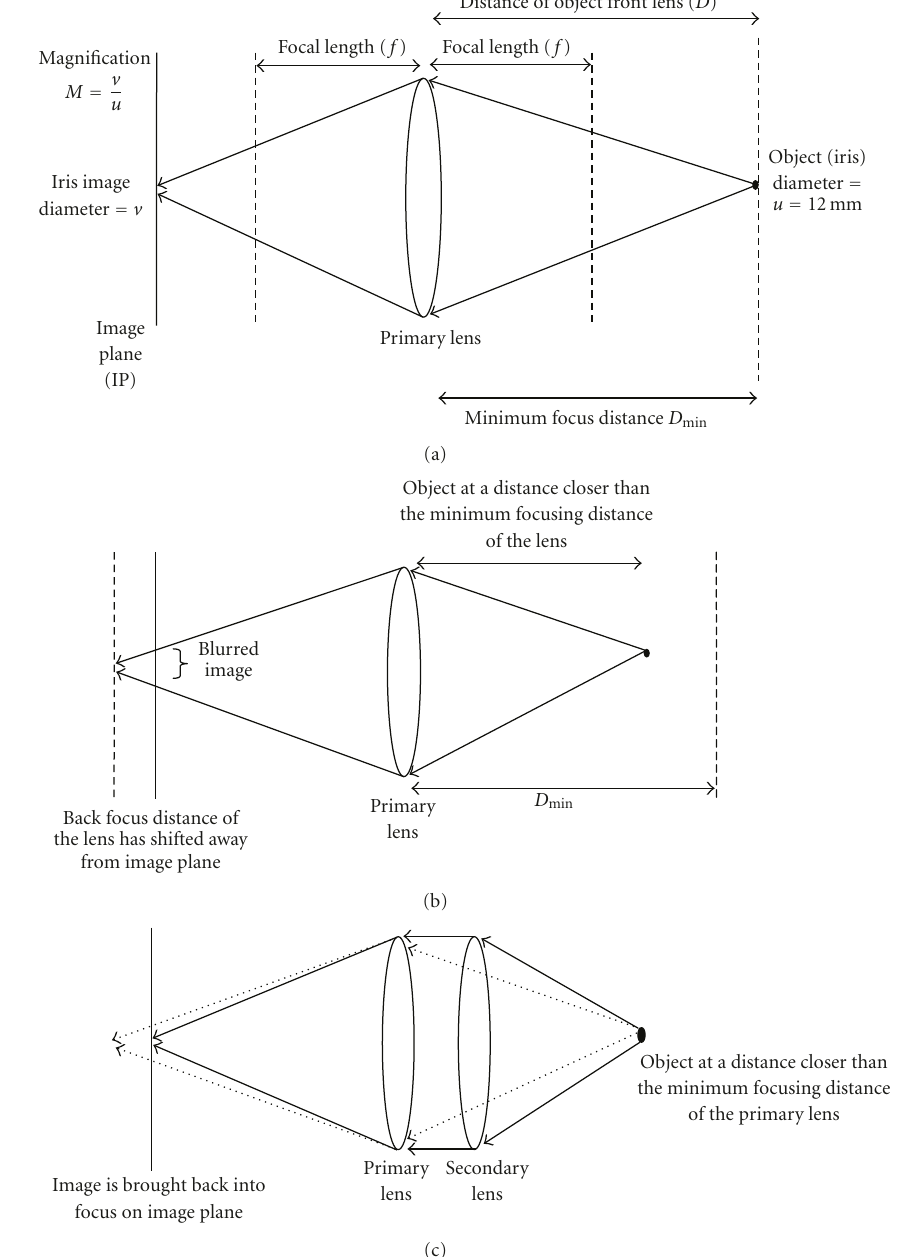
Figure 3: The figure illustrates how a secondary converging lens, used along with the primary lens, reduces the minimum focus distance of the system. (a) Shows an object place farther away than the minimum focus distance D min from the primary lens. (b) Shows an object placed closer to the primary lens. Here, the object is not in focus on the image plane IP. (c) Shows how the addition of a converging lens brings the image back into focus on the